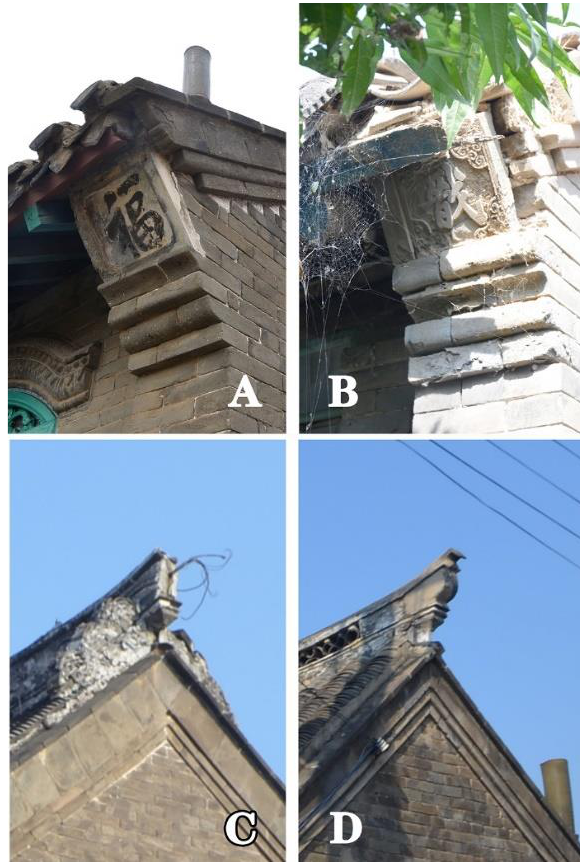
Figure 3. Decorations on vernacular houses in Liaoning Province. B and D show the complete decoration elements. C shows a mutilated element. A presents a simple replacement with drawings. Photo by Li Bing, 2019.